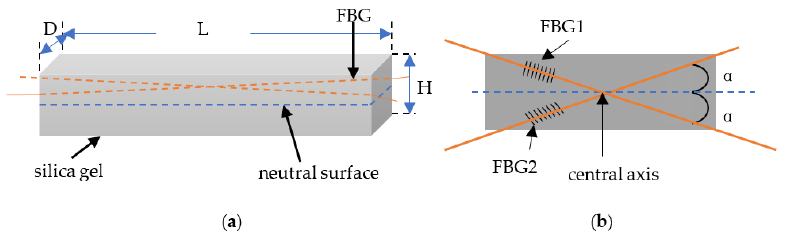
Figure 6. Structure diagram of the dual FBG high-precision shape sensor: ( a ) Dual FBG shape sensor structure Figure, ( b ) FBG layout Figure.